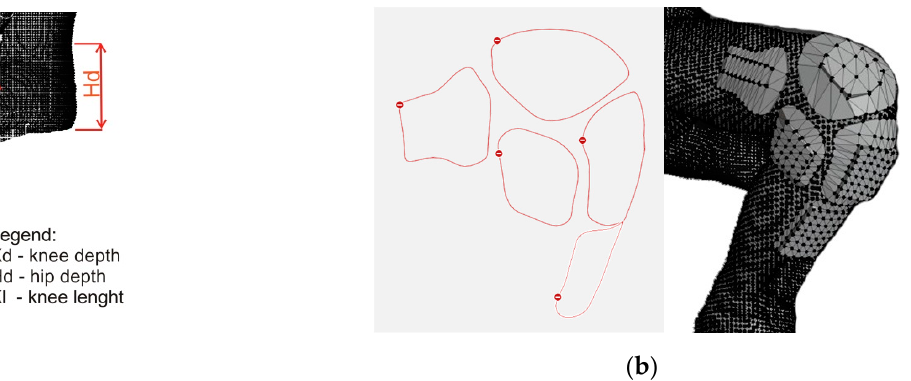
Figure 5. Defining body measures ( a ) and protector shape ( b ) according to the 3D human model.